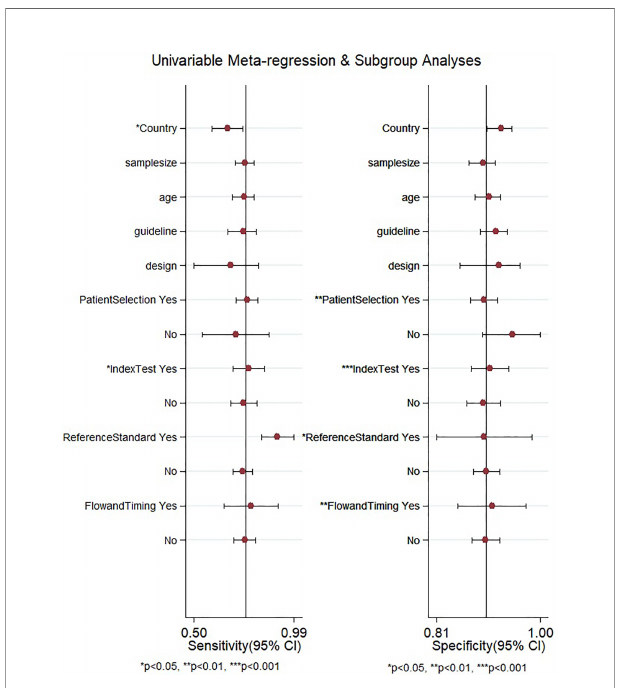
FIGURE 8 | Meta-regression to explore the source of heterogeneity among the studies reporting gadoxetic acid-enhanced MRI for diagnosing HCC. HCC, hepatocellular carcinoma.